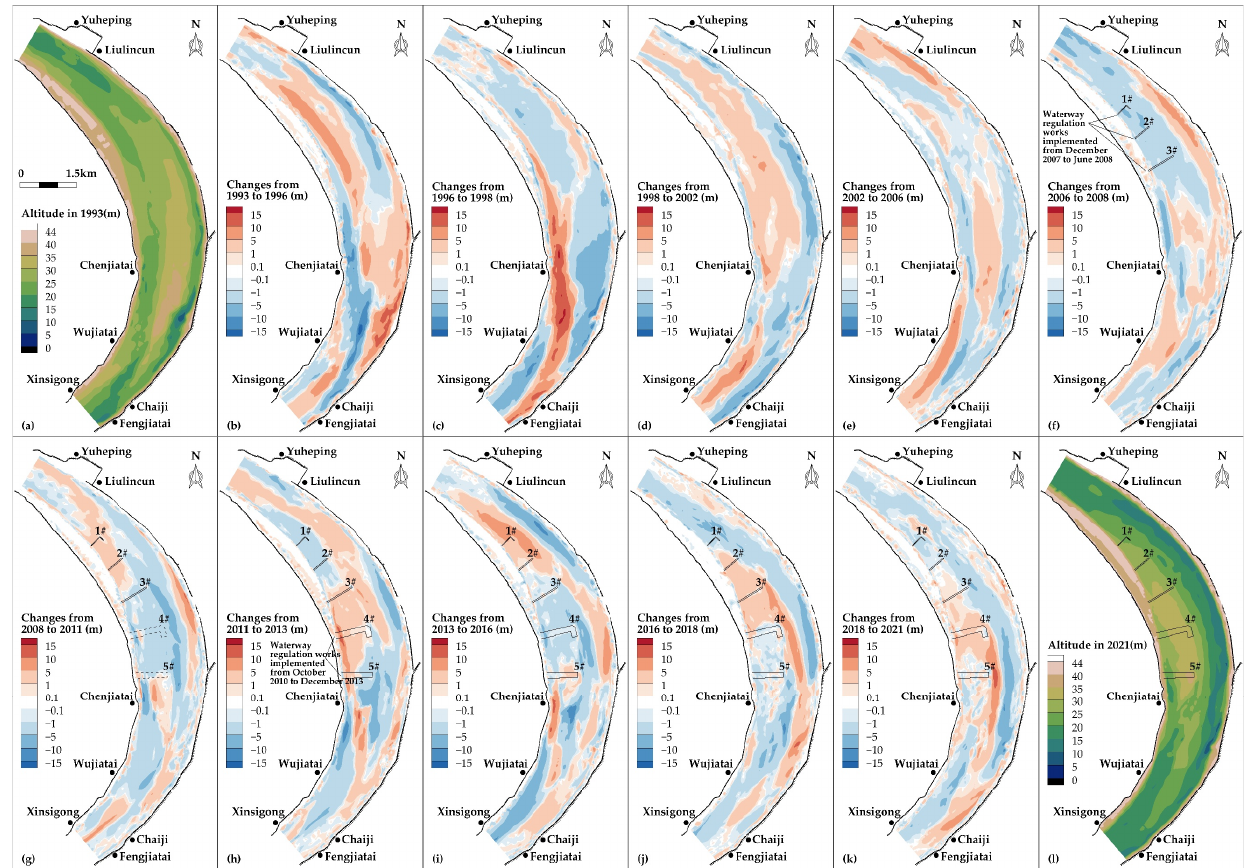
Figure 9. Riverbed topography and elevation from 1993 to 2021. ( a ) Riverbed topography in 1993; ( b )–( k ) Riverbed elevation net changes between two measurements; ( l ) Riverbed topography in 2021.